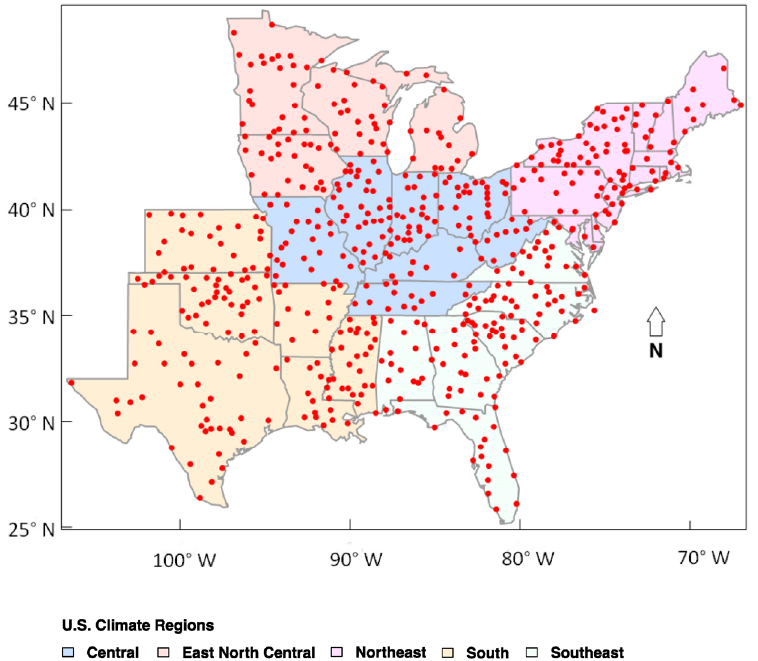
Figure 1. The eastern United States (eUS) with the locations of 583 Historical Climatology Network precipitation stations across the study region. Different colors represent five climatically consistent regions within eUS [Central (Ohio Valley), Northeast–Central (Upper Midwest), Northeast, South, and Southeast] (https://www.ncdc.noaa.gov/monitoring-references/maps/us-climate-regions.php (accessed on 12 December 2022)).